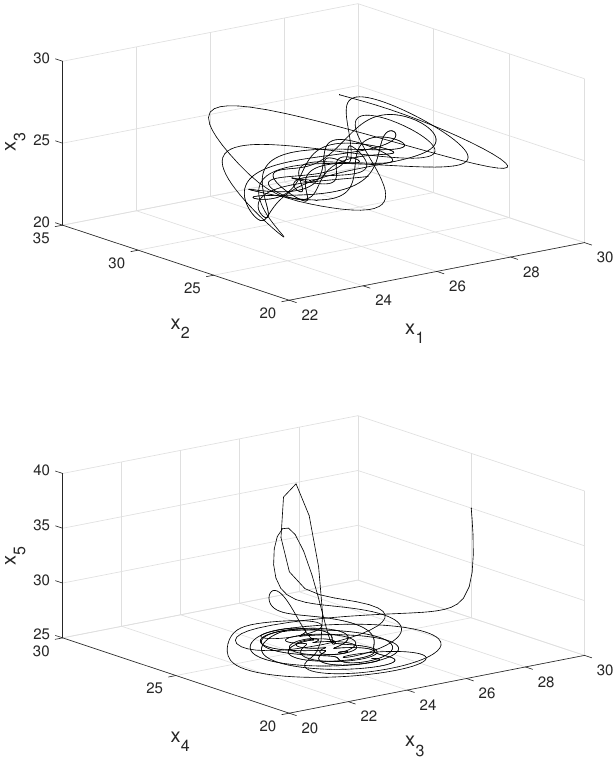
Figure 3. Projections in (cid:60) 3 of the chaotic attractor in (cid:60) 5 of the Rössler system which define the couplings between the nodes in the network, this projections include the